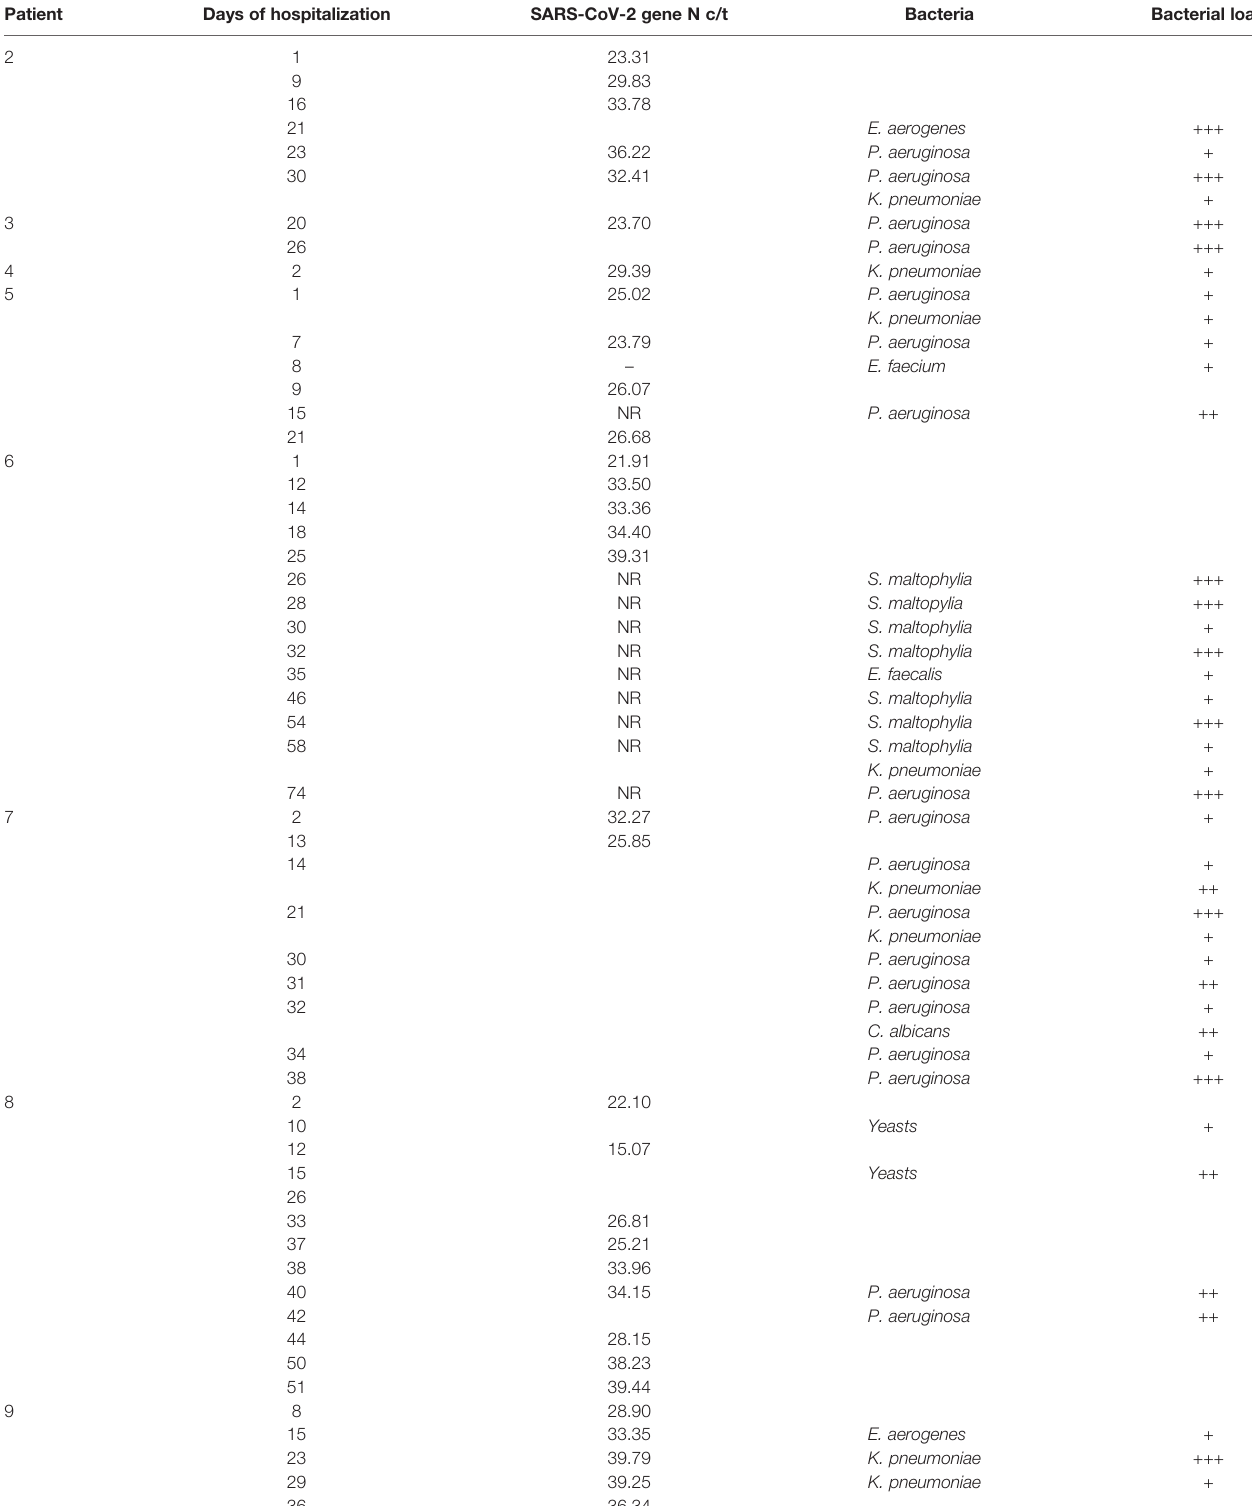
TABLE 1 | SARS-CoV-2 and bacteria detection for each patient with superinfection are reported with the SARS-CoV-2 gene N c/t and the bacterial identi fi cation and load at the corresponding day of hospitalization.